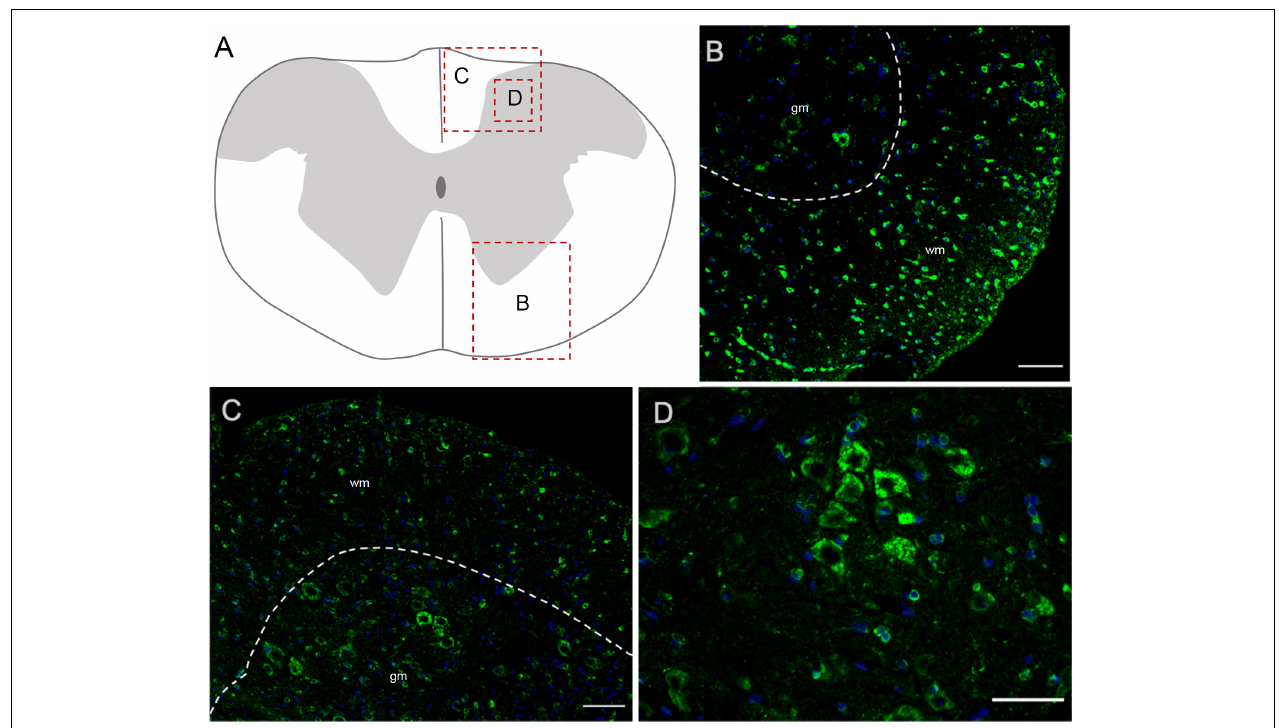
FIGURE 7 | Elovl5 in the spinal cord. (A) Schematic representation of a spinal cord coronal section and areas magnified showed in panels (B–D) . (B,C) Elovl5 (green) is strongly expressed by small cells in the spinal cord white matter and in a moderate way by motor neurons in the gray matter. (D) High magnification of large neurons of the dorsal horn, positive for Elovl5 staining (green). (B,C) wm, white matter; gm, gray matter. Scale bars: (B,C) 100 µ m and (D) 50 µ